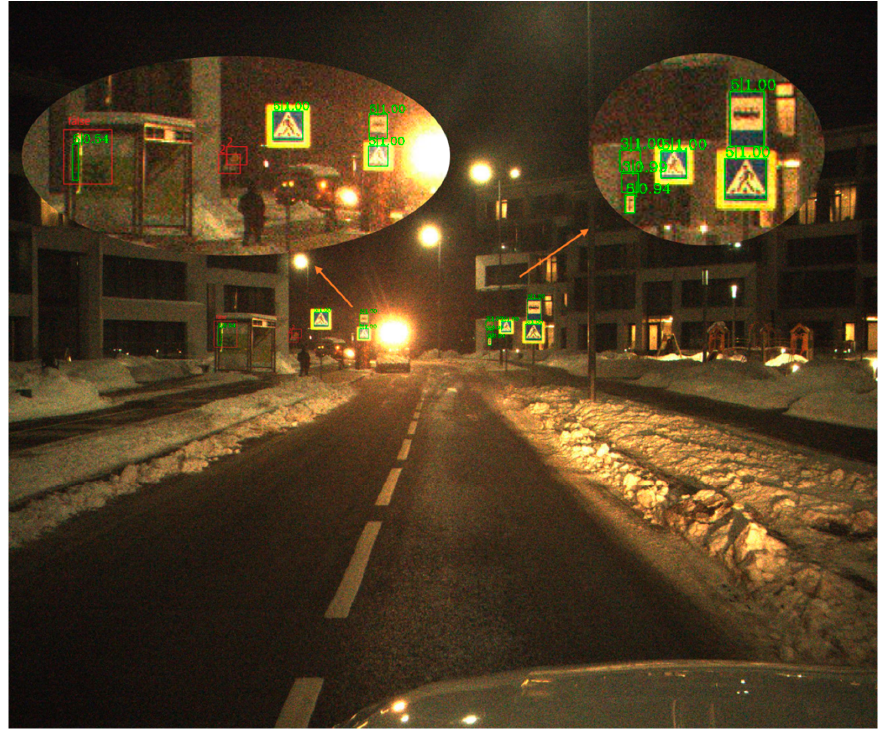
Figure 7. The visualization of the Faster-RCNN result on ITSDB detection. Green square represents detection result of the model, and red square represents target missed or detected